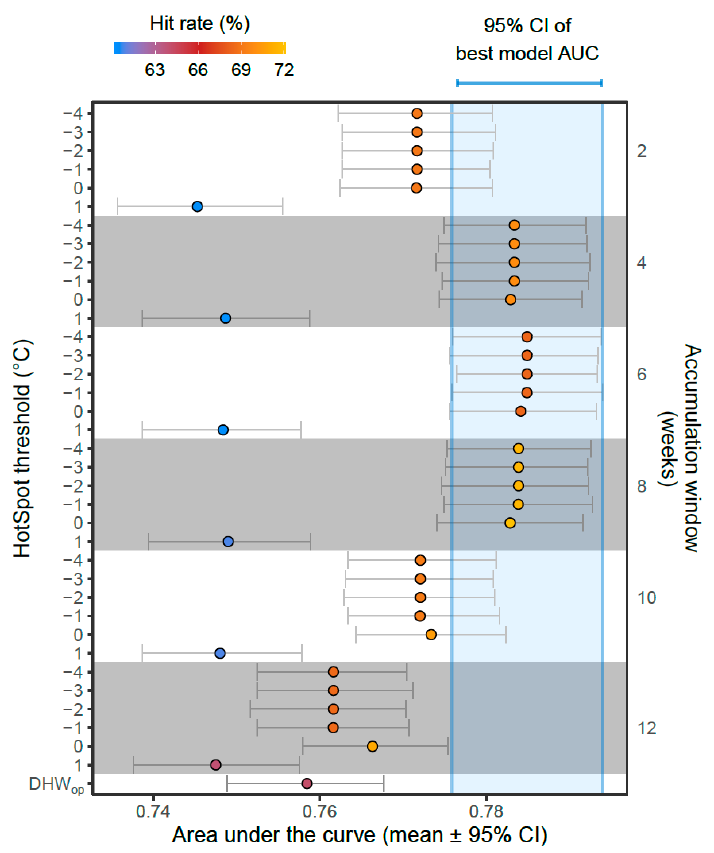
Figure 4. Model comparisons accounting for uncertainty in the area under the curve (AUC, derived from sensitivity– specificity analysis) showing the mean and 95% bootstrapped confidence intervals (CI). Each point represents a